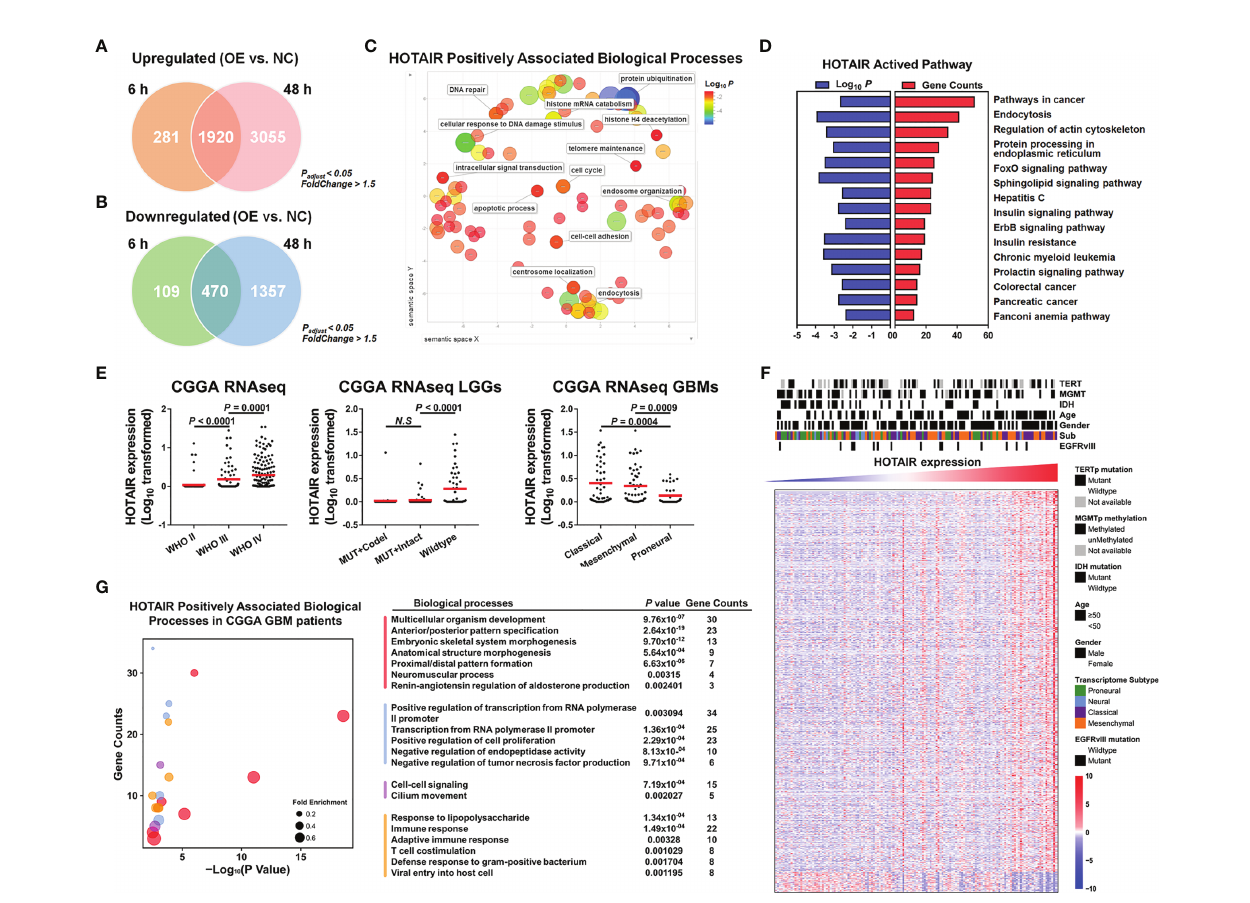
FIGURE 2 | HOTAIR regulated gene expression participated in multiple biological processes in different dataset. (A) HOTAIR upregulated 2201 genes after 6h expressing in U87 and 4975 genes after 48h, respectively, and there were 1920 overlapping genes. (B) HOTAIR downregulated 579 genes and 1827 genes when HOTAIR were expressed for 6h and 48h in U87 respectively, and the overlapping genes reached 470. (C, D) HOTAIR regulated genes were enriched in several biological processes (C) and pathways (D) . (E) HOTAIR expression in CGGA RNAseq dataset (n=301). (F) Cluster heatmap showed the gene expression level correlated with HOTAIR expression in glioma based on CGGA RNAseq dataset (n=301). (G) Quanti fi able genes of GBM patients in CGGA RNAseq dataset associated with HOTAIR were classi fi ed by ontology annotation based on biological